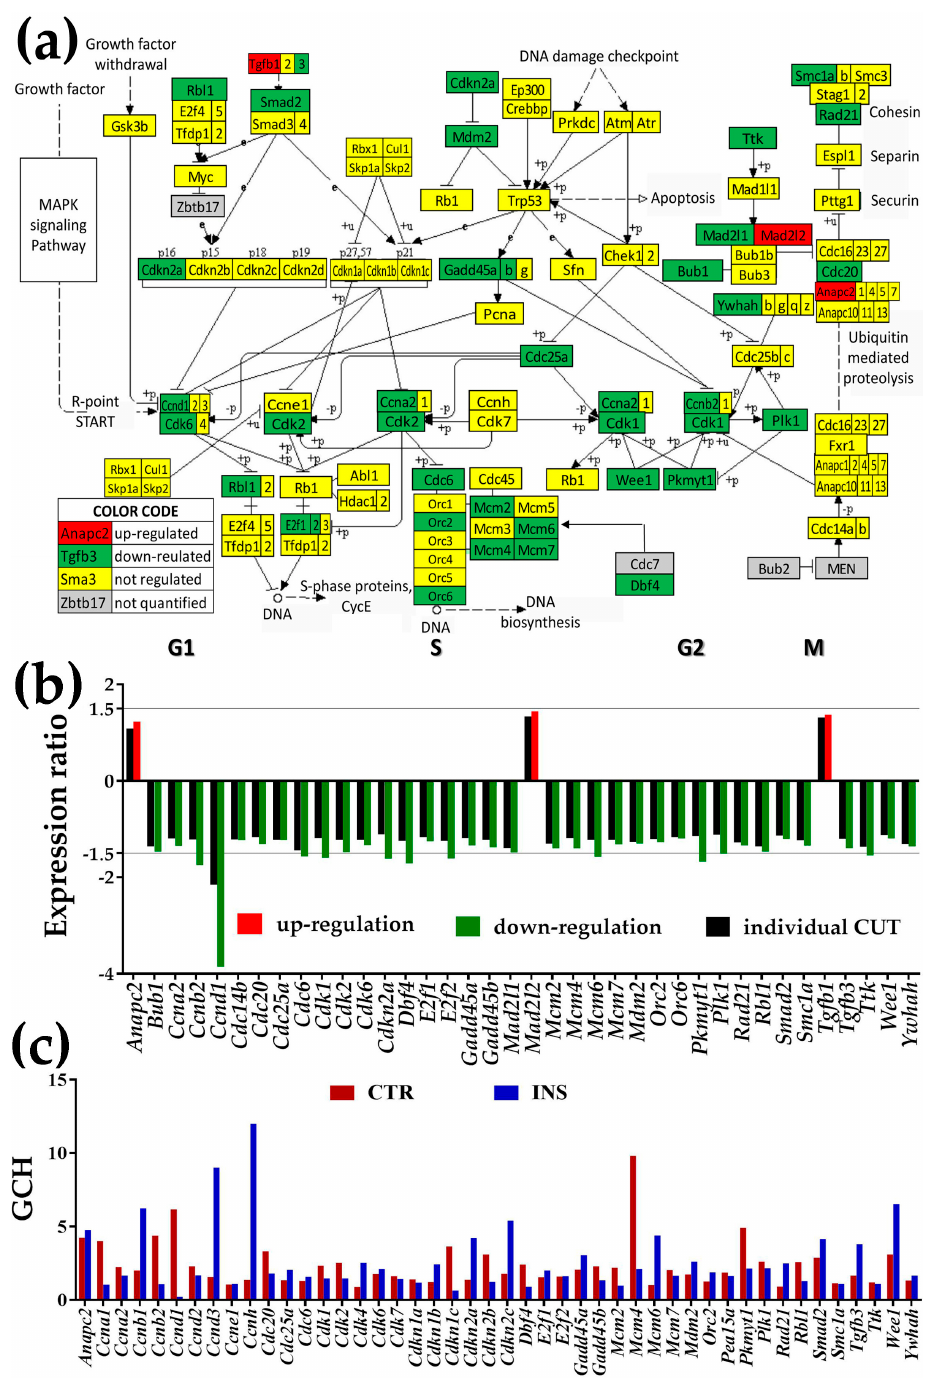
Figure 3. Presence of non-touching Oli-neu cells a ff ects cell-cycle (CC) pathway genes (modified from https: // www.genome.jp / kegg-bin / show_pathway?mmu04110). ( a ) Regulation of the interconnected genes within the CC pathway. ( b ) Expression ratios and individual fold-change cut-o ff s (negative for down-regulation) of the significantly regulated genes. Note that the individual gene cut-o ff for Ccnd1 (CUT = 2.152) exceeded 1.5 × . ( c ) Gene Commanding Height (GCH) scores of the significantly regulated CC genes and other quantified cyclins ( Ccna1, Ccnb1, Ccnd2, Ccnd3, Ccne1, Ccnh ) and kinase inhibitors ( Cdkn1a, Cdkn1b, Cdkn1c, Cdkn2b, Cdkn2c). Mcm4 (GCH = 9.81) was the highest ranked CC gene in CTR and Ccnh (GCH = 12.01) the highest ranked CC gene in cocultured with Oli-neu astrocytes .